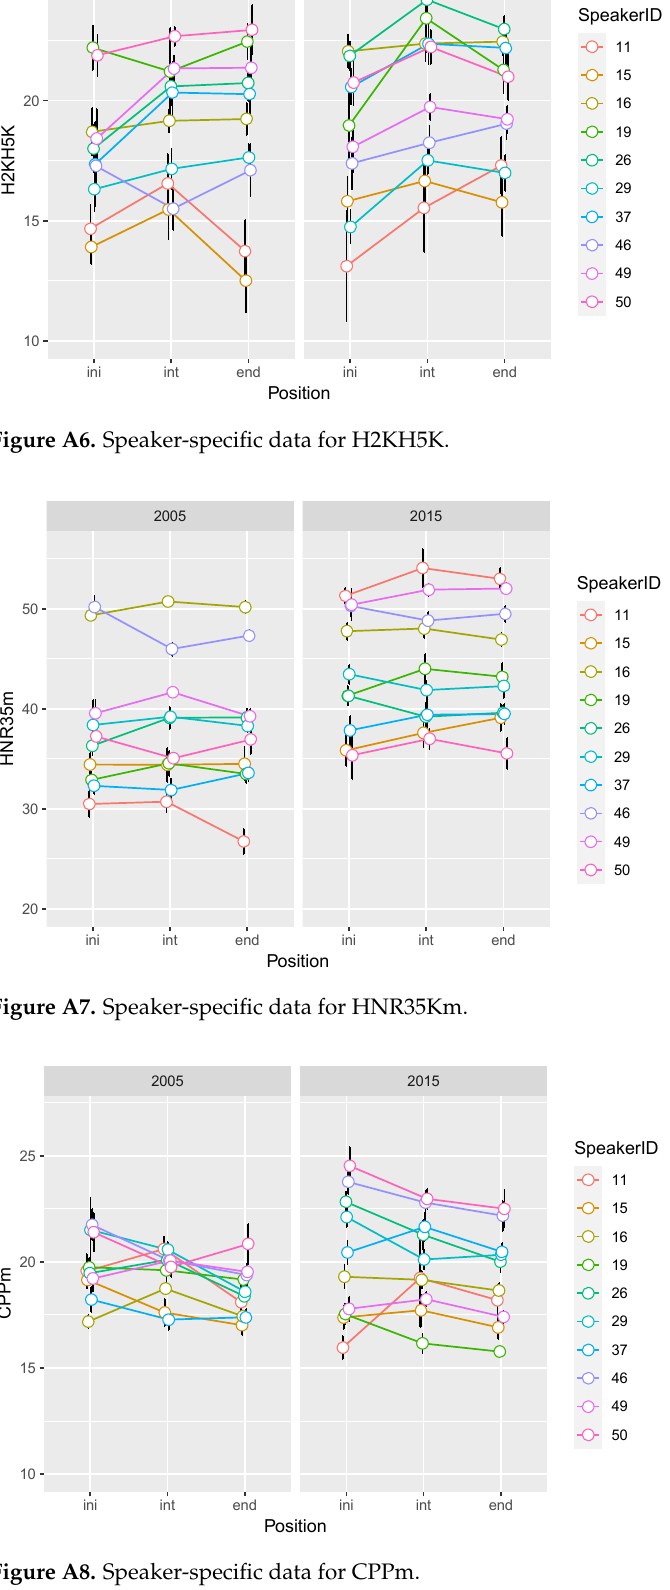
Figure A8. Speaker-specific data for CPPm.